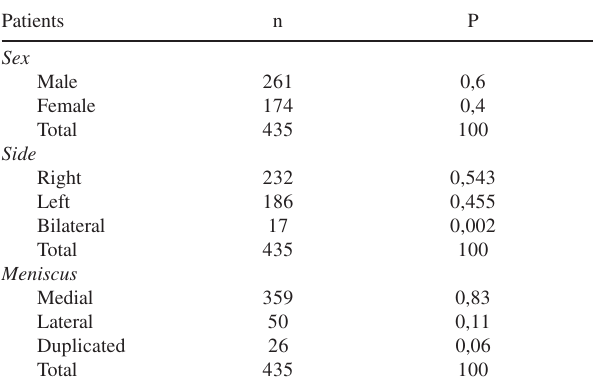
Table 1 - Distribution of patients with meniscal injury according to sex, age, side affected, and injured meniscus Patients